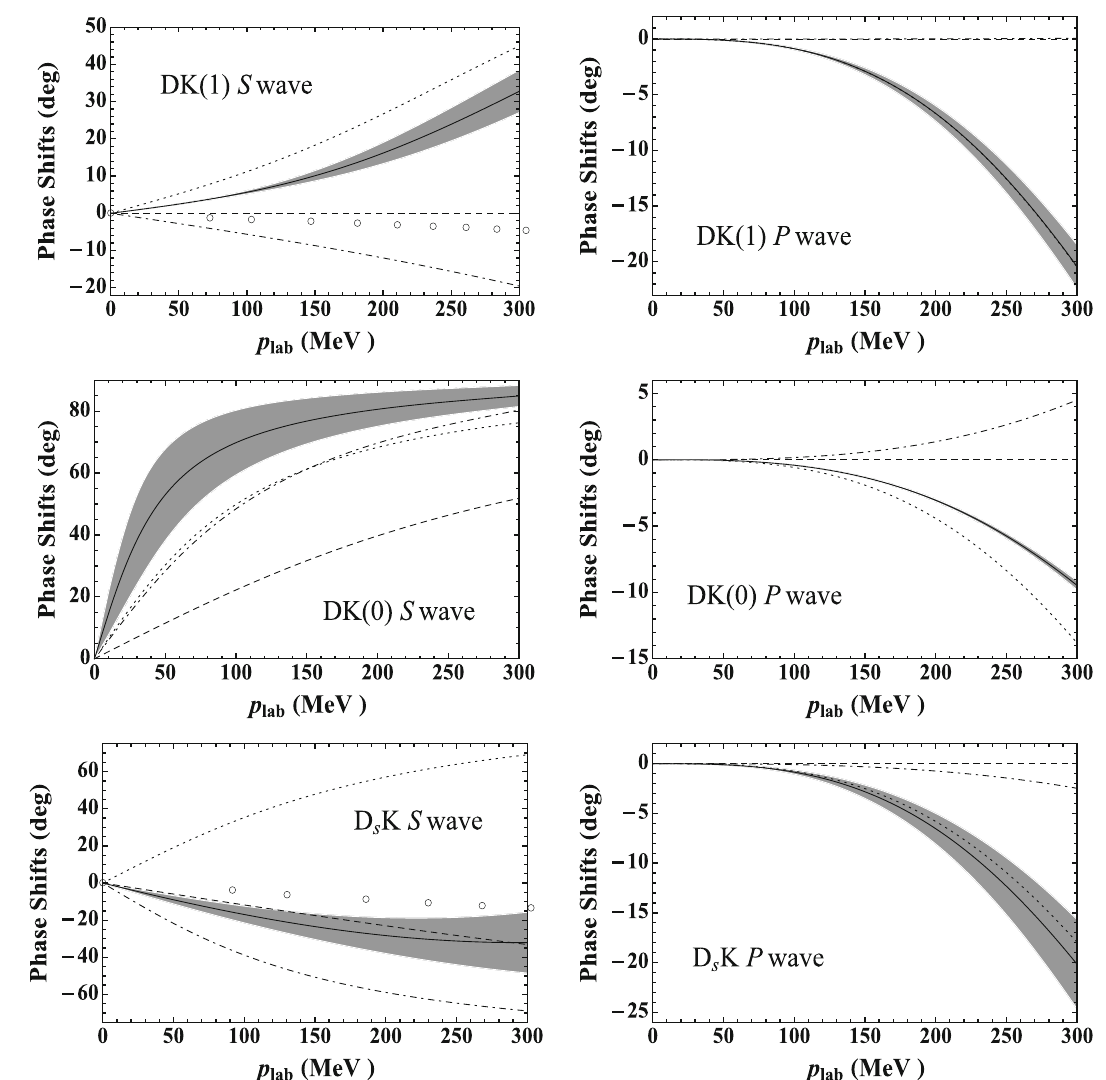
Fig. 4 Predictions for the kaon- D meson phase shifts versus the kaon laboratory momentum at physical meson values. The notation is the same as in Fig.